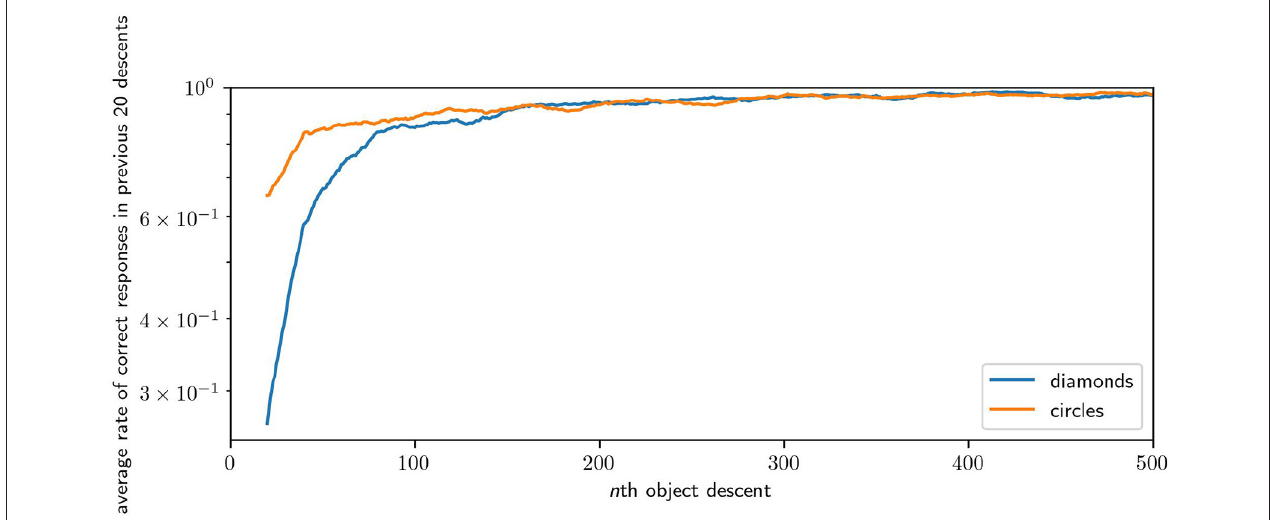
FIGURE 16 | Results of an inversion of the default task, in which the responses properties of diamonds and circles are swapped. This causes the robots to develop to avoid circles instead of diamonds and vice versa . Results are presented as per Figure 12 , note that the learning rates are equivalent but the robots take longer to respond correctly to diamonds instead of circles in this